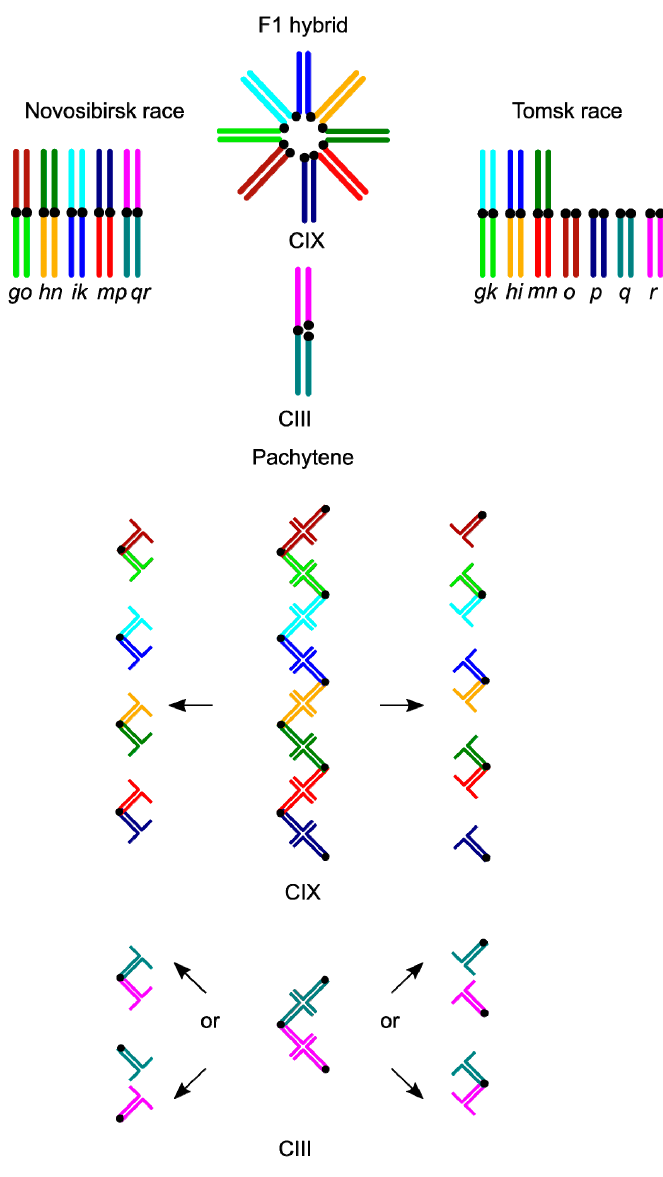
Figure 1. Expected meiotic configurations of the shrews of Novosibirsk and Tomsk races and their hybrids at pachytene (above) and later in the first meiotic division (below). Homologous arms are labelled and colour coded. Only balanced anaphase I complements are shown.